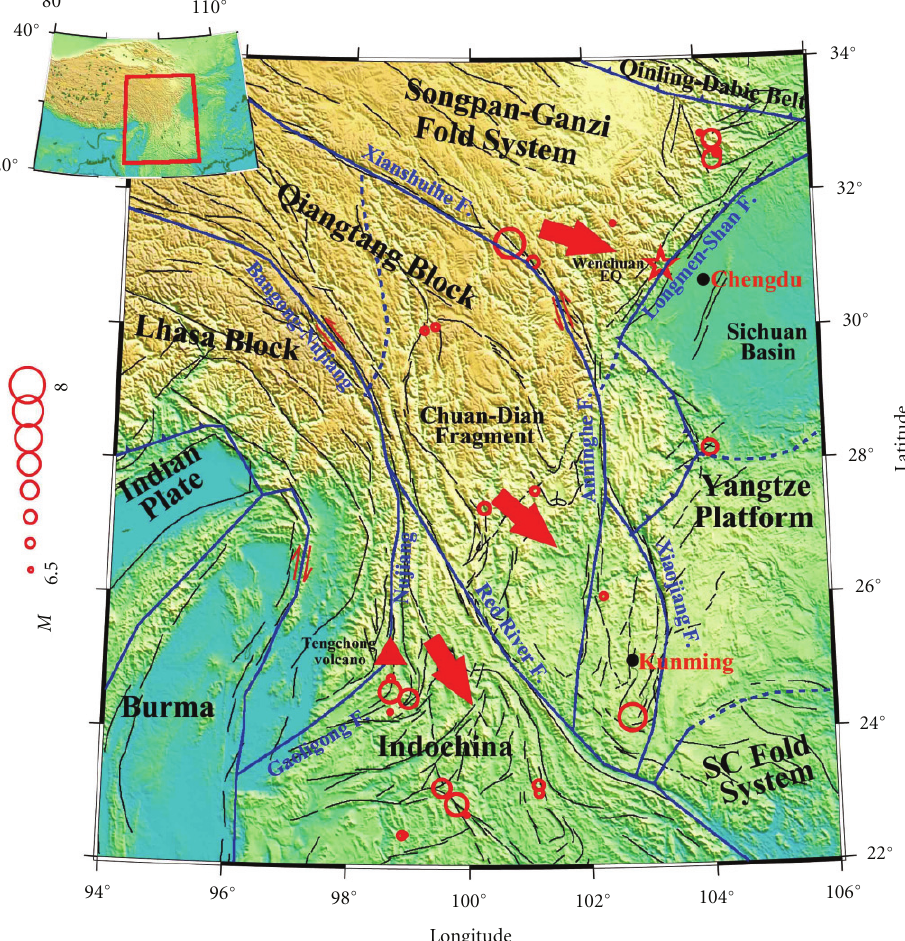
Figure 1: Topography and tectonic framework of the Southeastern Tibetan Plateau. Blue solid lines indicate the deep, large sutures, and main tectonic boundaries. Black thin lines show the active faults. Red open circles show the locations of the large historic earthquakes ( M > 6 . 5) occurred from 1913 to 2008. Three red arrows indicate the rotation directions of the Songpan-Ganzi fold system, the Qiangtang and Indochina Blocks, respectively. Magnitude scale of the earthquakes is shown on the left. A red box in the inset map shows the present study